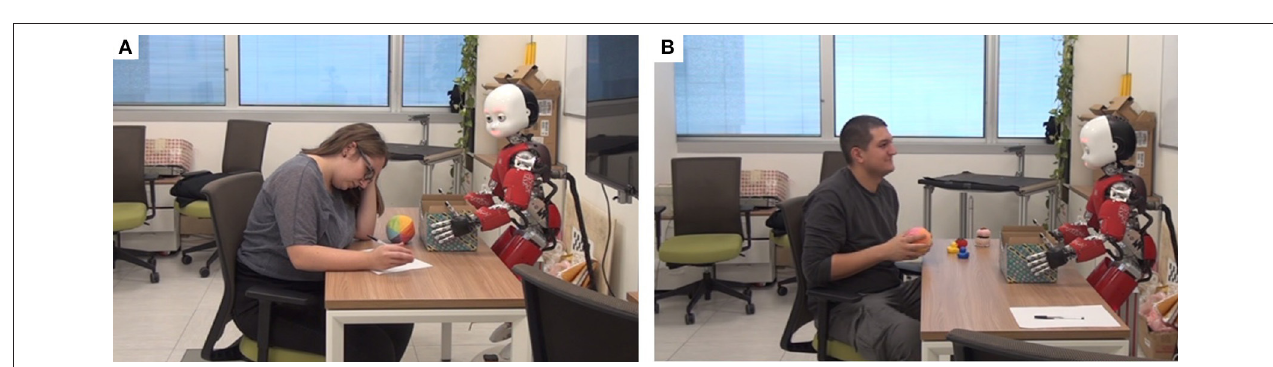
FIGURE 6 | Number of occurred and responded threshold hits per session for FA and AF participants.